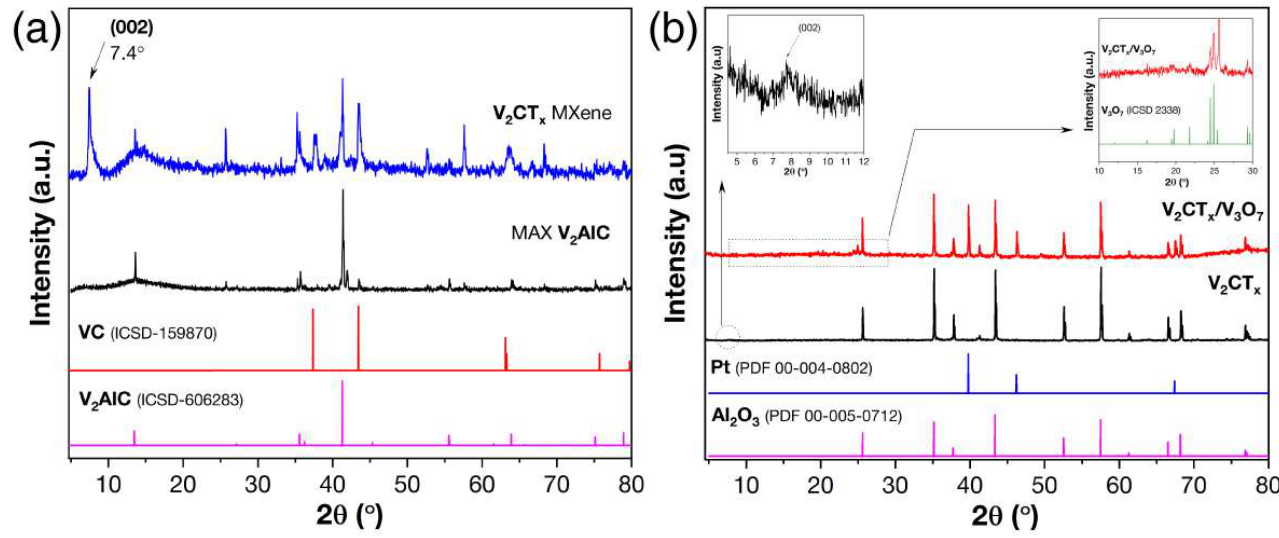
Figure 1. X-ray patterns of the V 2 AlC MAX-phase and the obtained accordion-like V 2 CT x MXene powder ( a ), as well as V 2 CT x MXene films on Al 2 O 3 /Pt substrates before and after in situ oxidation with insets of characteristic bands for the corresponding V 2 CT x MXene (left) and V 3 O 7 (right) phases ( b ).